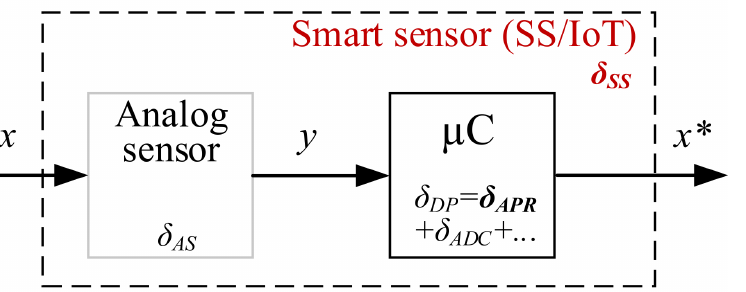
Figure 2. The basic structure and main error components of the smart sensor/IoT (after piecewise linear approximation and analog–digital conversion; x* —microcontroller output